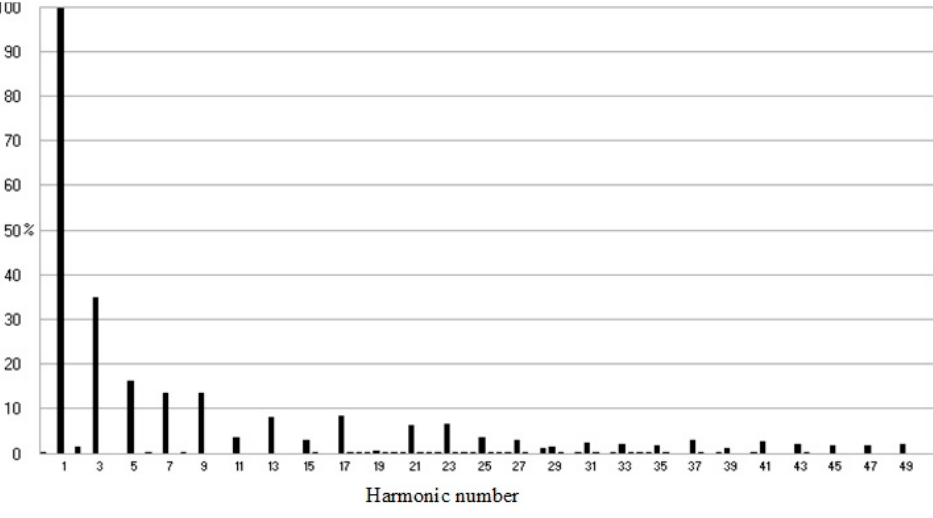
Figure 12. Set of lighting equipment: harmonic spectrum and current total harmonic distortion factor. THD I = 46.3%.